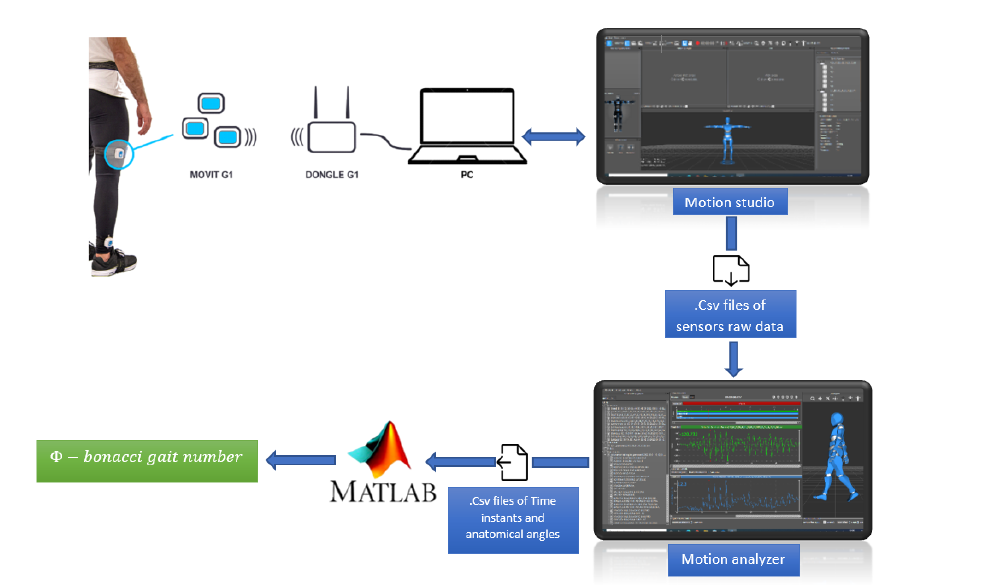
Figure 3. Flow chart. The wearable wireless sensors start to acquire and record the movement data in their internal memory with a sample rate of 200 Hz after the recording button is pressed on the